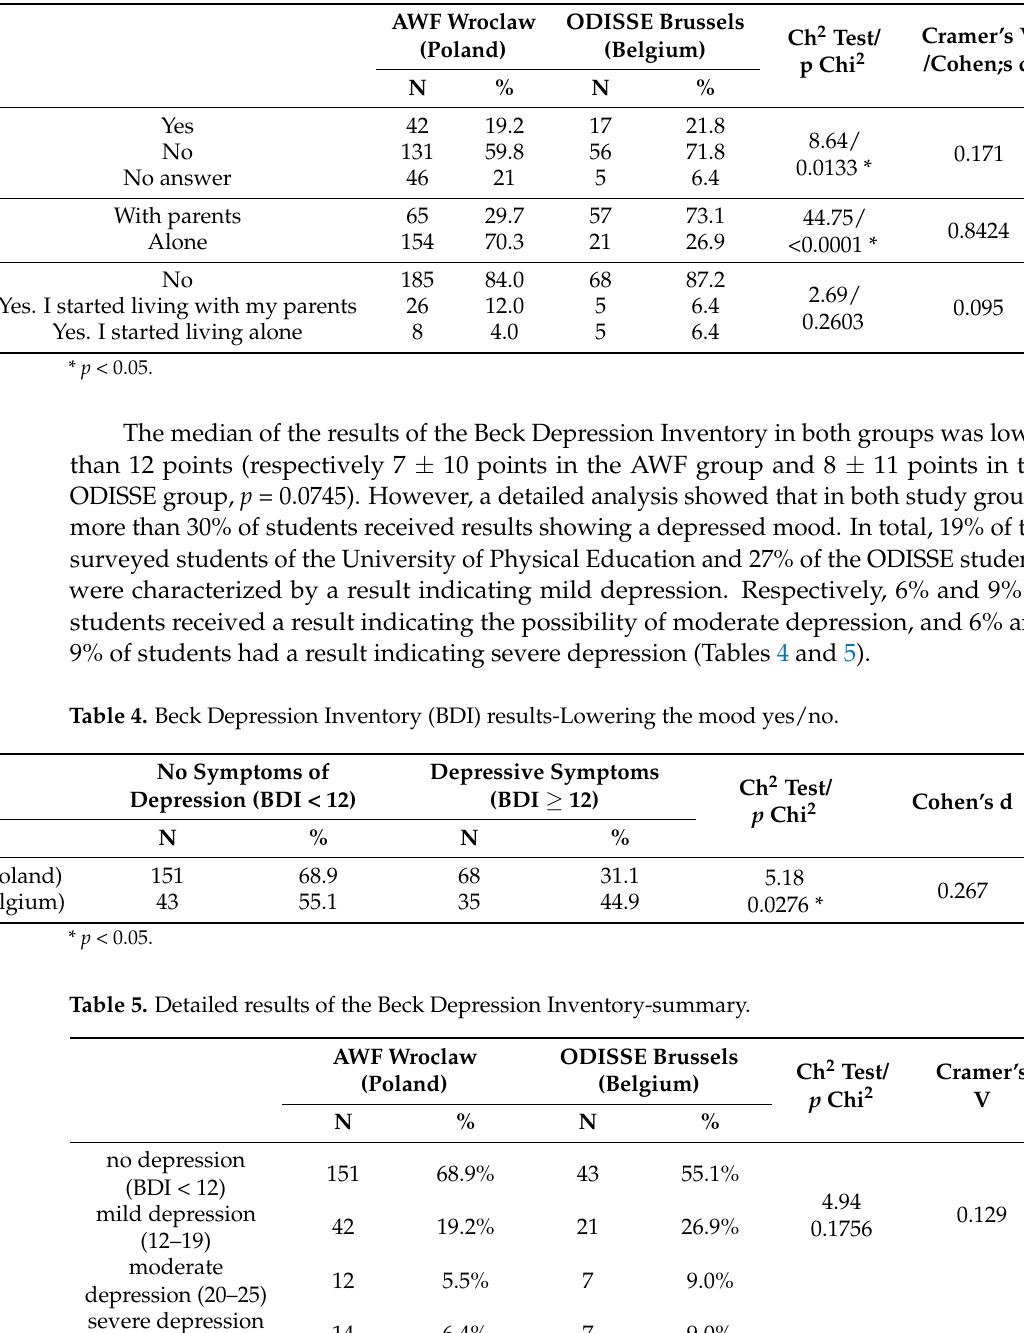
Table 3. Characteristics of the study groups.